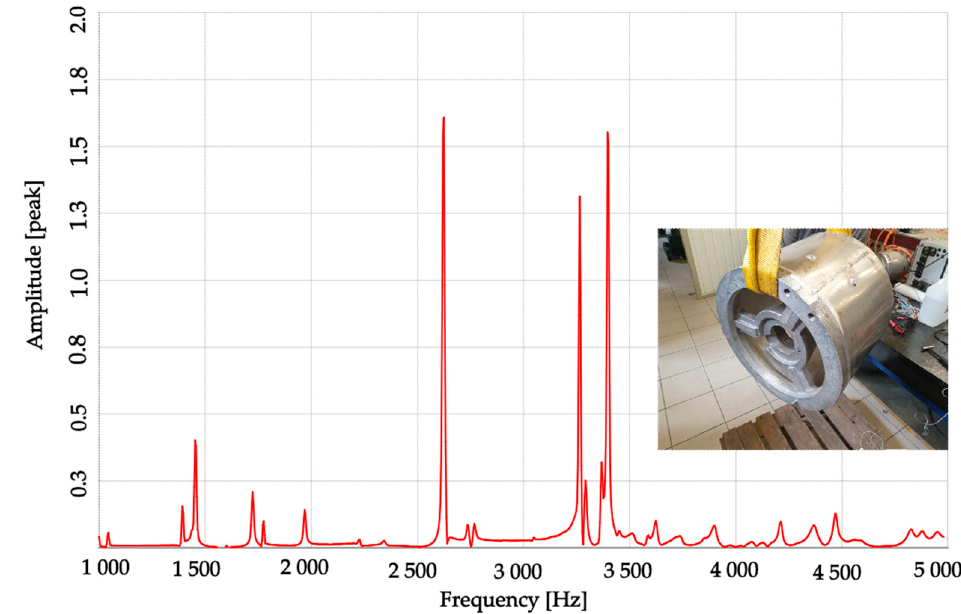
Figure 3. Modal analysis of the motor housing, x axis: frequency and y axis amplitude of sound response of the housing.